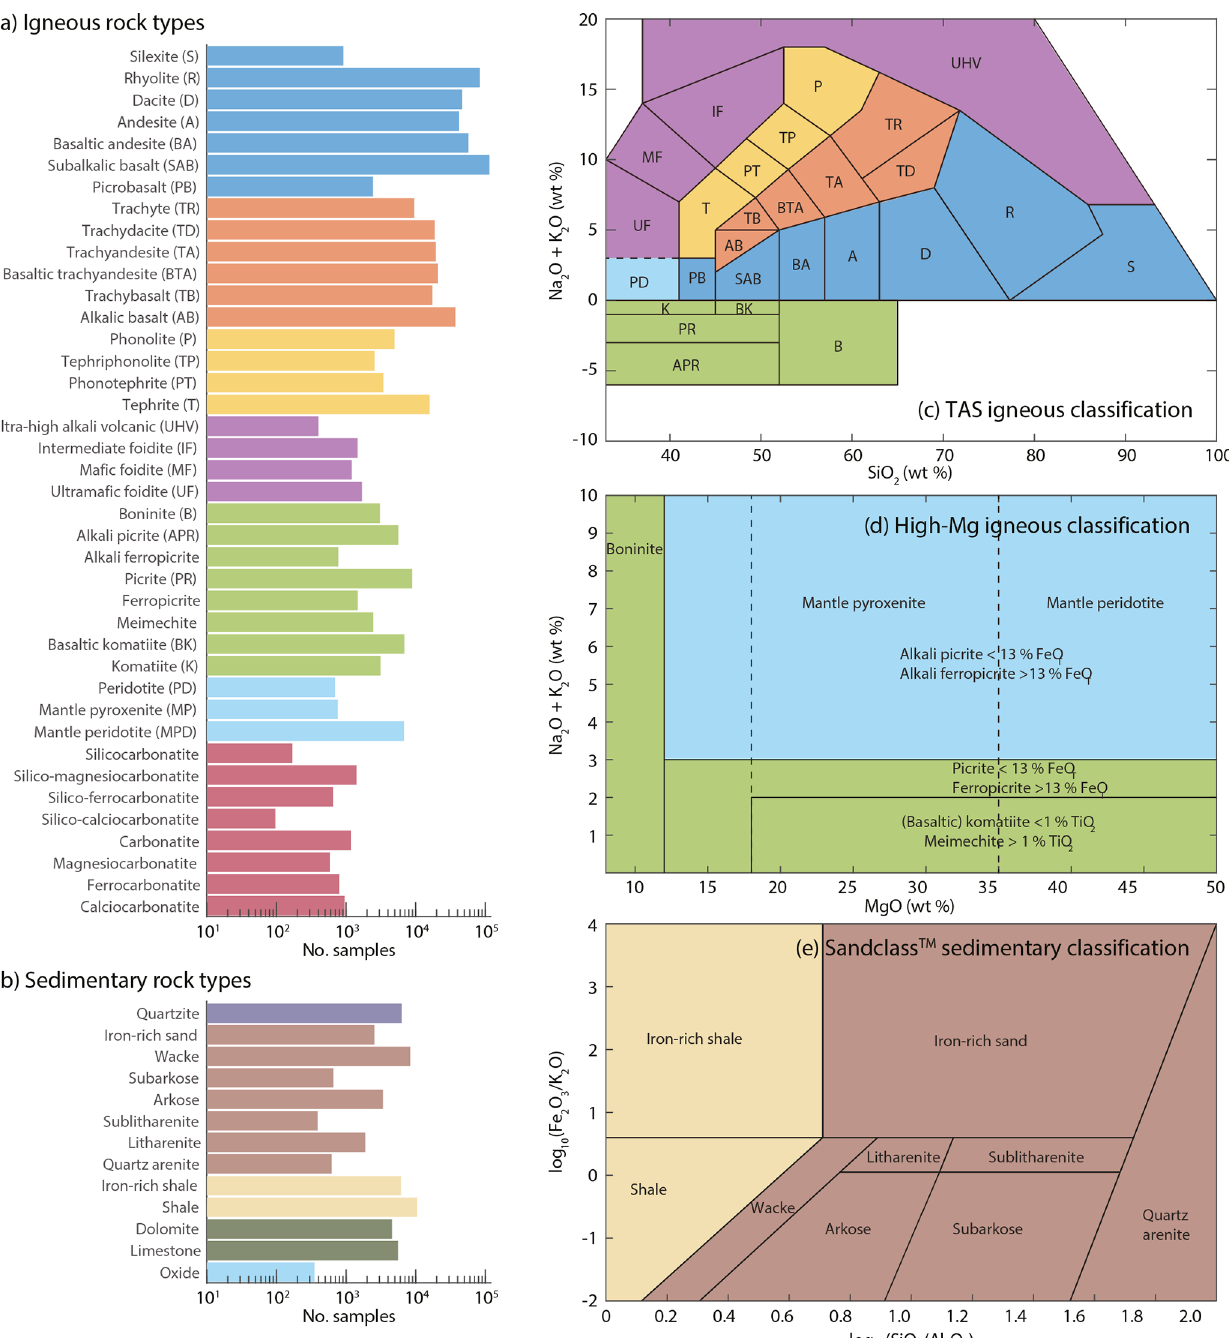
Figure 6. Rock-type classification information. (a) Igneous and meta-igneous sample histograms of assigned rock names. (b) Sedimentary and metasedimentary sample histograms of assigned rock names. (c) TAS igneous classification (Middlemost, 1994). (d) High-Mg igneous classification. See Le Bas and Streckeisen (1991) for further information on classification methods. (e) Sedimentary classification, after Herron (1988) (Sandclass ™